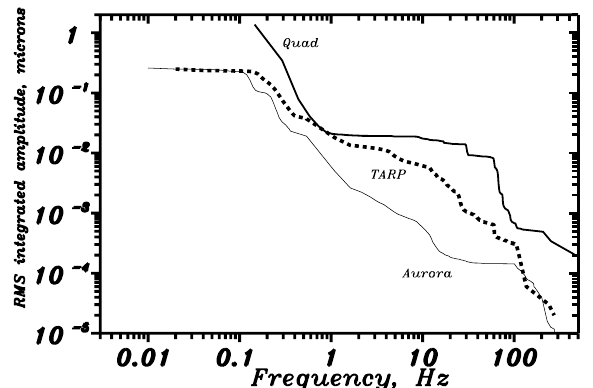
FIG. 14. Integrated rms ground motion amplitude.